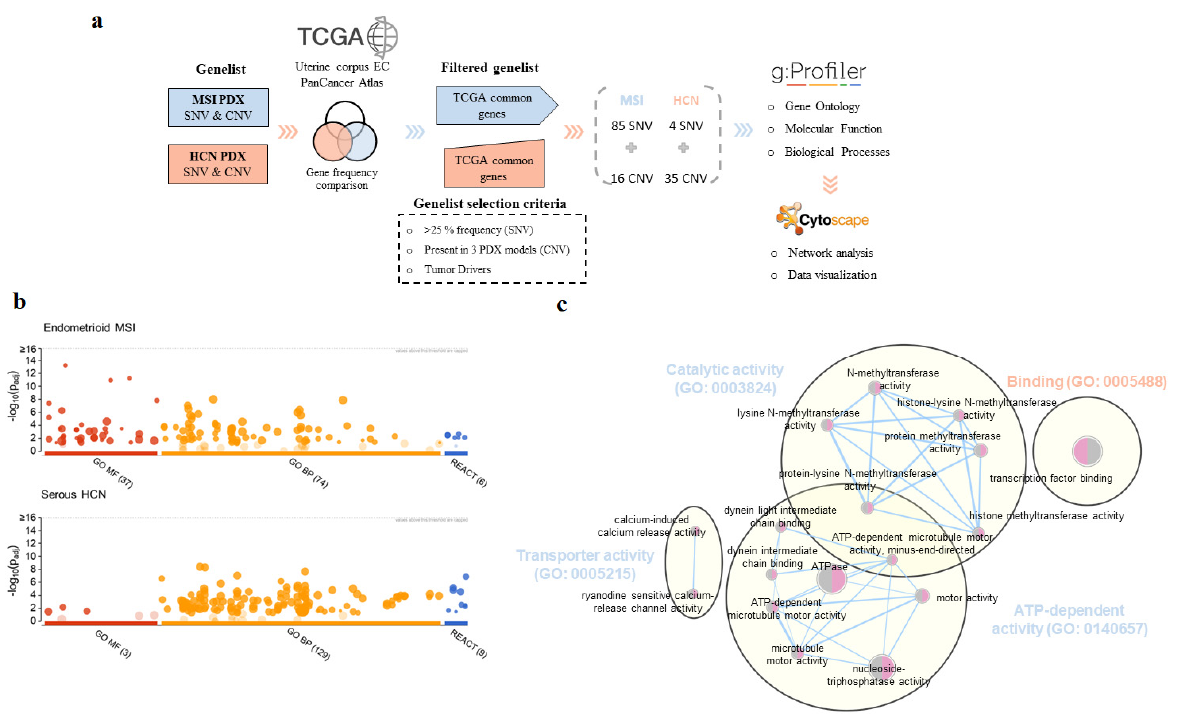
Figure 6. Molecular network analysis for the identification of relevant pathways associated with MSI or HCN profiles. ( a ) Schematic representation of the workflow followed for the identification of the most relevant genes carrying SNVs or involved in CNV events. A list of 101 genes (MSI), or 39 genes (HCN) were determined for each PDX group, according to the gene selection criteria described. ( b ) Molecular function (MF), biological process (BP) and reactome pathways (REACT) functional enrichment analysis of the most relevant genes of MSI and HCN PDX models. The plots show GO terms associated with a specific gene list for MSI ( upper panel ) or HCN ( lower panel ) PDX models. ( c ) Gene ontology (MF) network of the most relevant genes associated with MSI (blue terms) or HCN (orange terms). GO terms network analysis was performed by Cytoscape and terms were summarized using the AutoAnnotate application selecting a Q-value < 0.01 and a combined coefficient of 0.375.